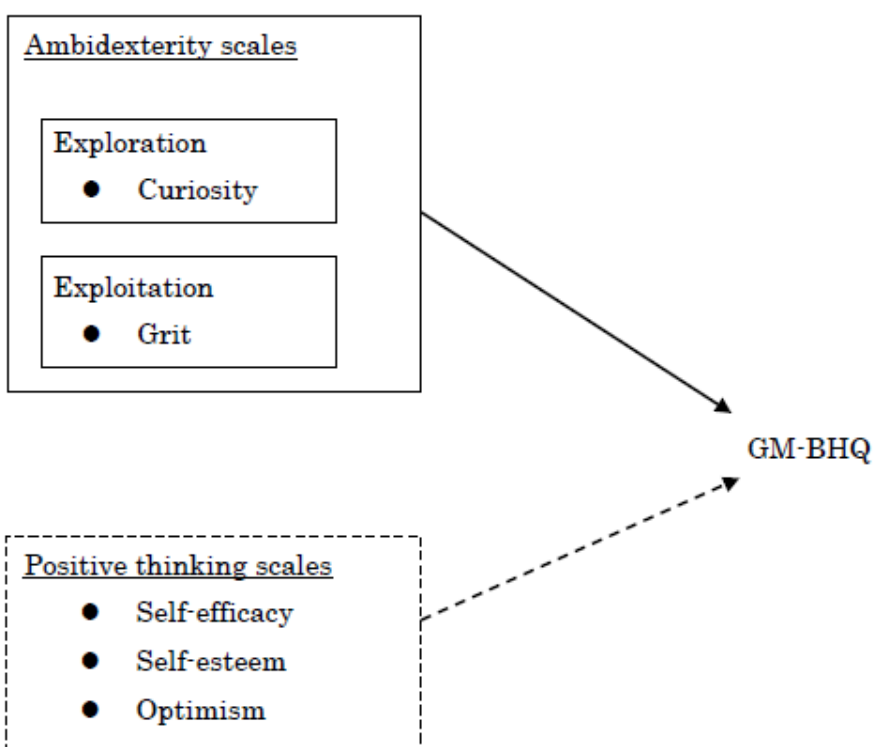
Figure 1. Expected association between psychological scales and the gray-matter brain healthcare quotient (GM-BHQ).